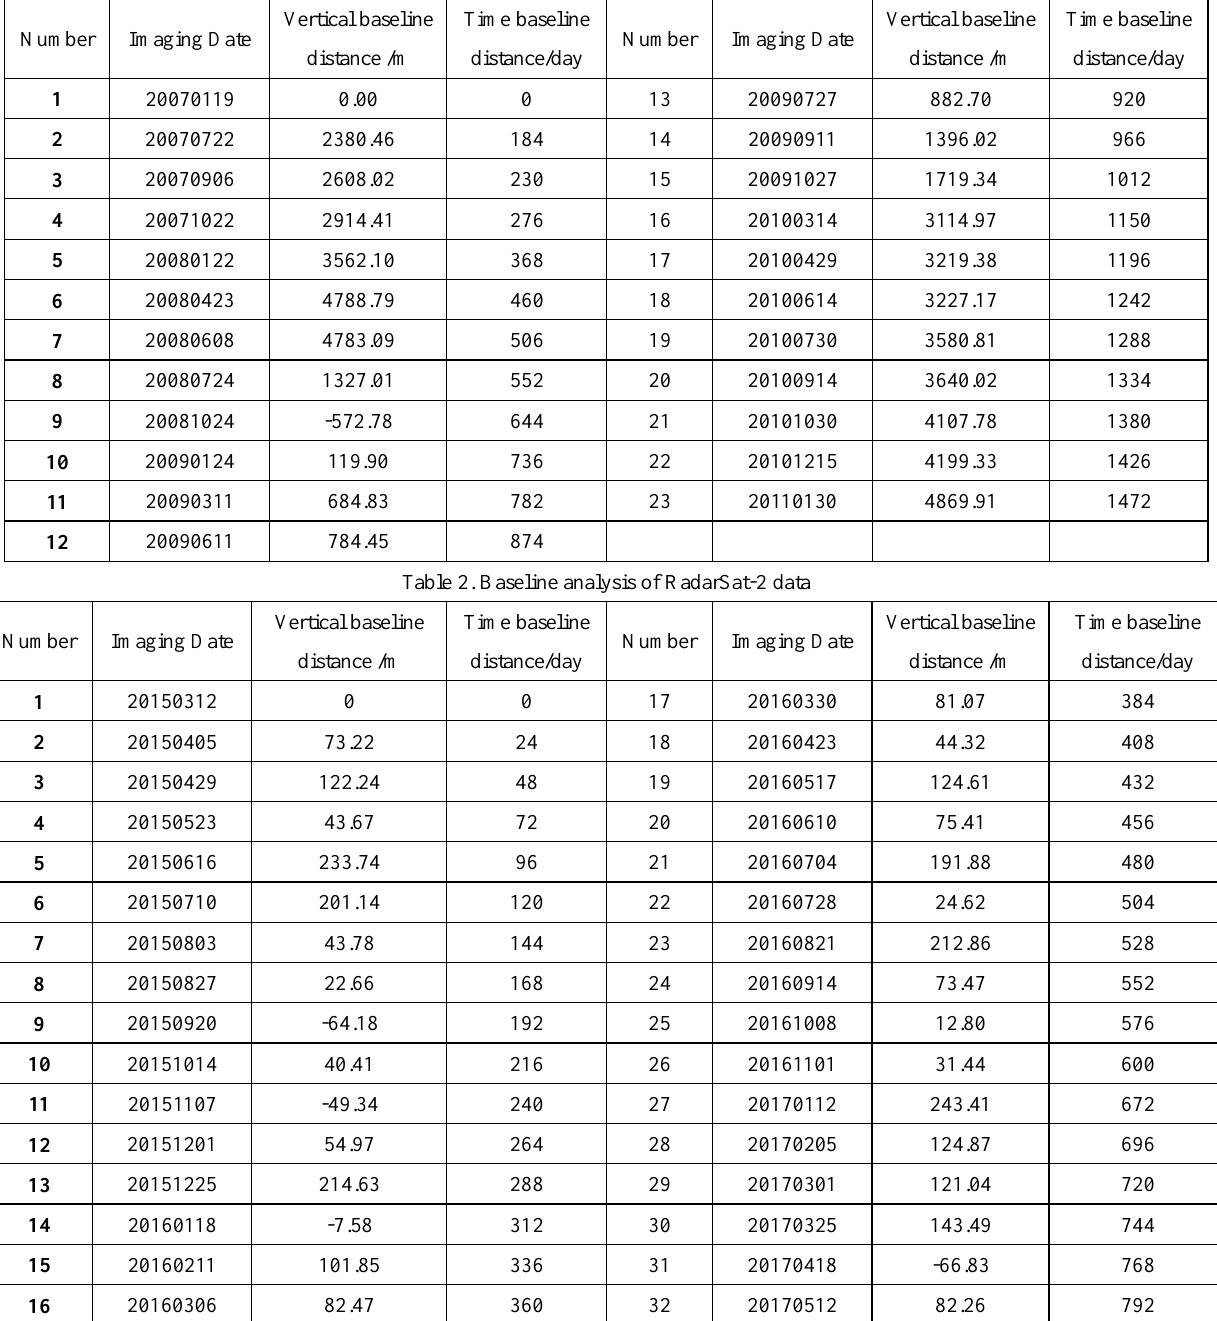
Table 1. Baseline analysis of ALOS-PALSAR data